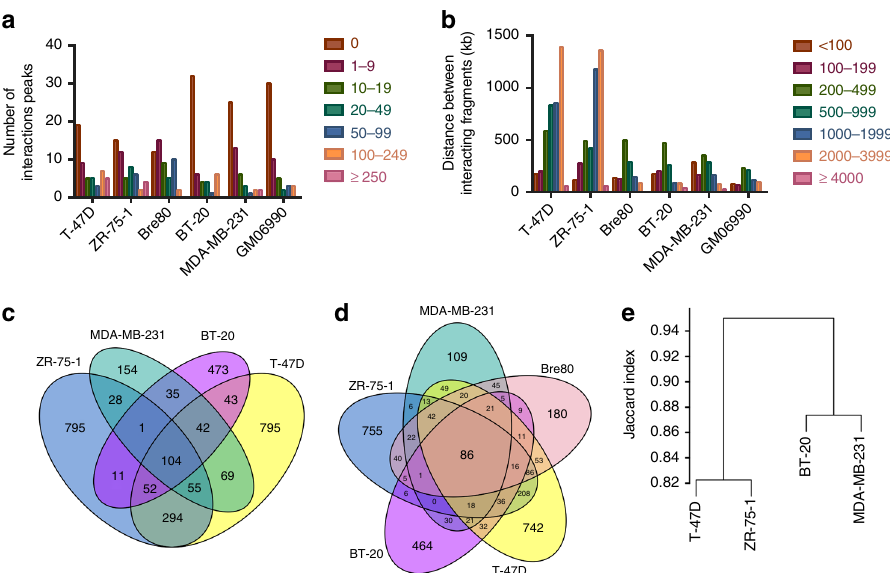
Fig. 1 Cell-type-speci fi city of interaction peaks at 51 informative breast cancer risk loci. Bar charts showing ( a ) the number of loci at which there were 0, 1 – 9, 10 – 19, 20 – 49, 50 – 99, 100 – 249 or >250 interaction peaks and ( b ) the number of interaction peaks at which the distance between interacting fragments are <100, 100 – 199, 200 – 499, 500 – 999, 1,000 – 1,999, 2,000 – 3,999, ≥ 4,000 kb for each cell line analysed. c , d Venn diagrams illustrating the overlap between interacting fragments in ( c) the four breast cancer cell lines and ( d) the fi ve breast cell lines. e Dendogram showing Jaccard dissimilarity scores (i.e. 1 — similarity coef fi cient) for the four breast cancer